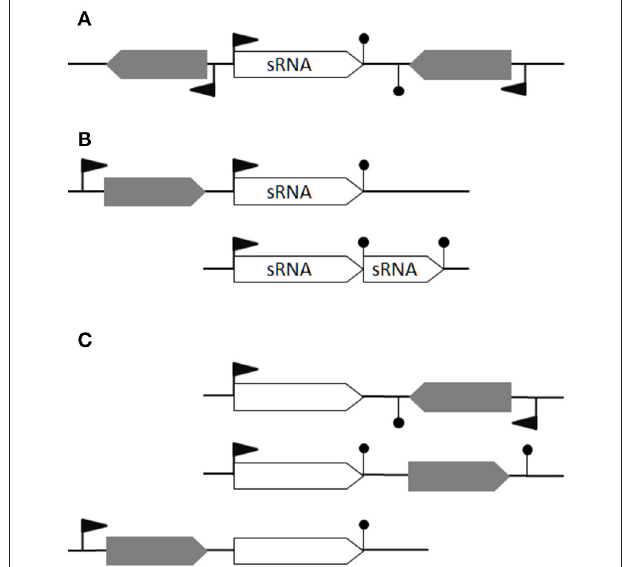
FIGURE 1 | Defining bona fide sRNAs. (A) An ideal bona fide sRNA gene has its own promotor and transcriptional terminator. Its transcription does not overlap any antisense transcription. (B) In the first case, transcription from the second promoter leads to a bona fide sRNA while the transcription from the first promoter would likely generate a transcript with a long 3 ′ UTR (e.g., RsaG). In the second case, a transcriptional termination read-through generates an alternative longer sRNA (e.g., RsaE-S390). (C) Three examples of non-coding RNAs not considered as bona fide sRNAs: a putative asRNA, a cis -regulatory element and a long 3 ′ -UTR, respectively. Flag: promotor; hairpin loop: terminator; gray arrow: open reading frames; empty arrow: non-coding